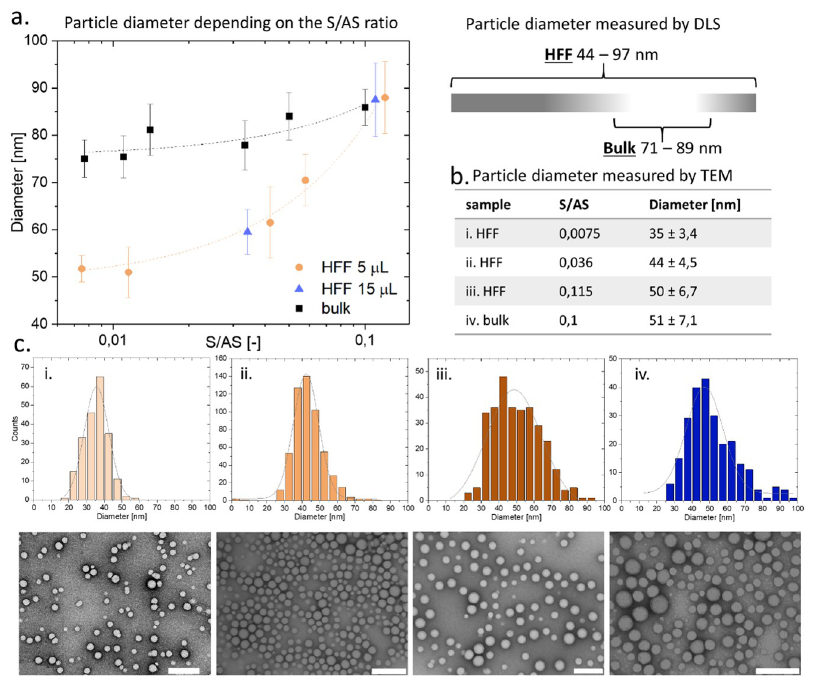
Fig 2. Particle size analysis. a. Particle diameter measured by DLS, (left) represented in the function of the S/AS flow ratio and (right) schematically illustrated dependency on the formulation method (bulk and HFF—hydrodynamic flow focusing); b. table with an average particle diameter obtained from analysis of TEM images; c. Particle size distribution obtained from TEM analysis (top row) and the corresponding TEM images (bottom row), scale bar 200